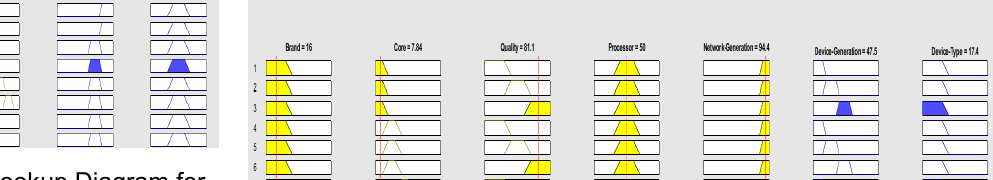
Figure 4. Proposed HKCFIS Model Lookup Diagram for 2nd generation of laptop